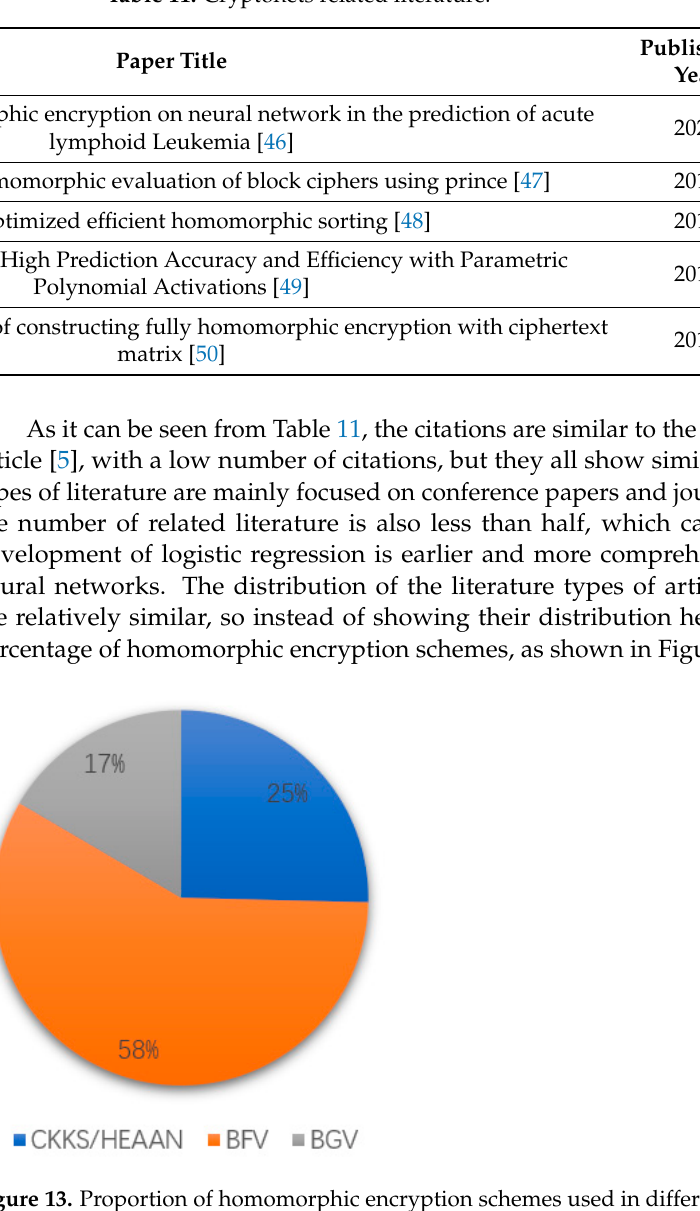
Figure 14. Ranking of contributions by different countries. 21232441 4143434547 5051